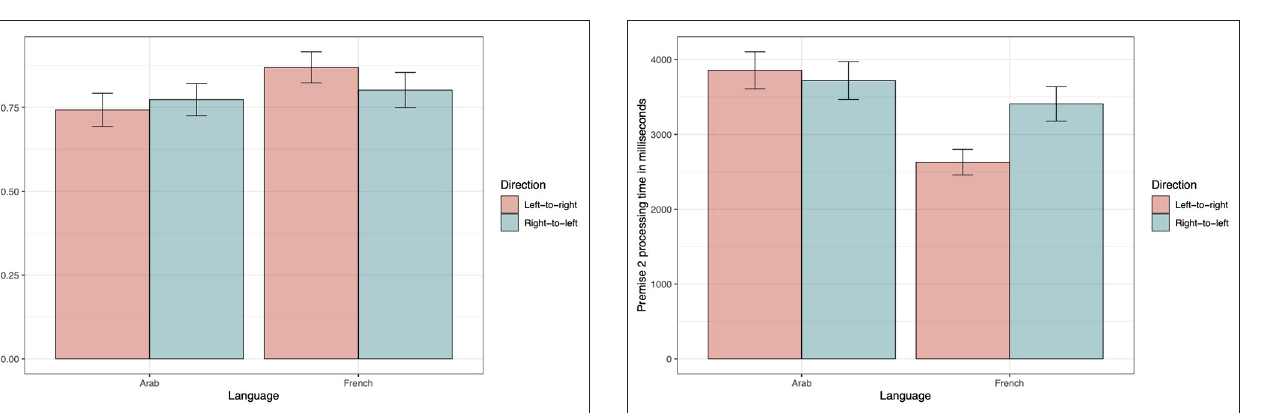
FIGURE 5 | Accuracy as a function of Direction and Language. The within-subjects 95% confidence intervals were computed following the method proposed by Morey (2008) and were implemented using the R functions developed by Chang (2018).